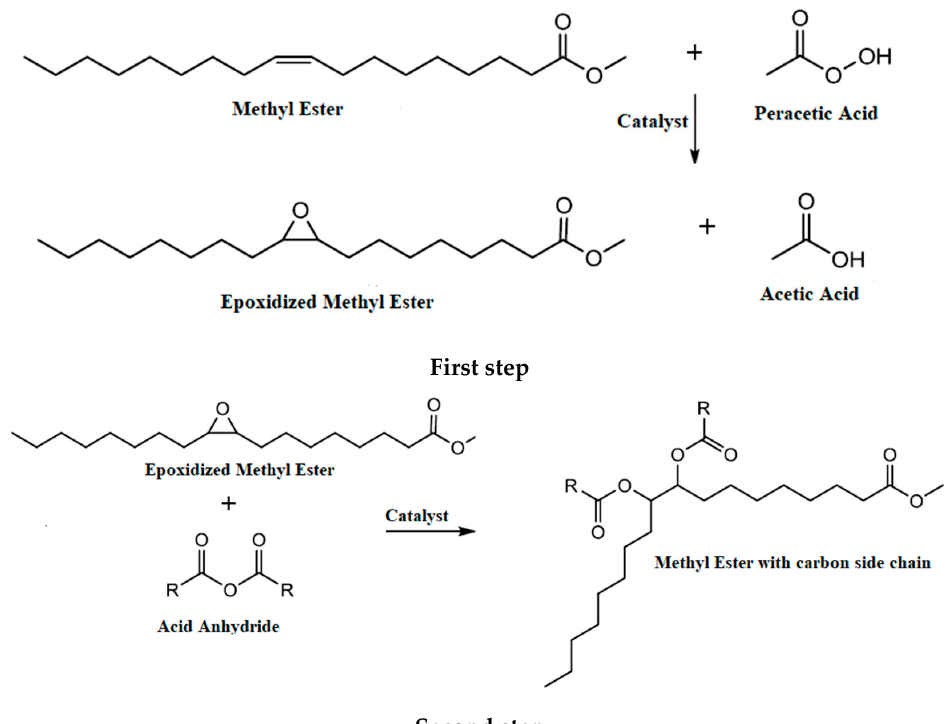
Figure 4. Reaction scheme of the first and second steps for epoxidation and grafting [5].